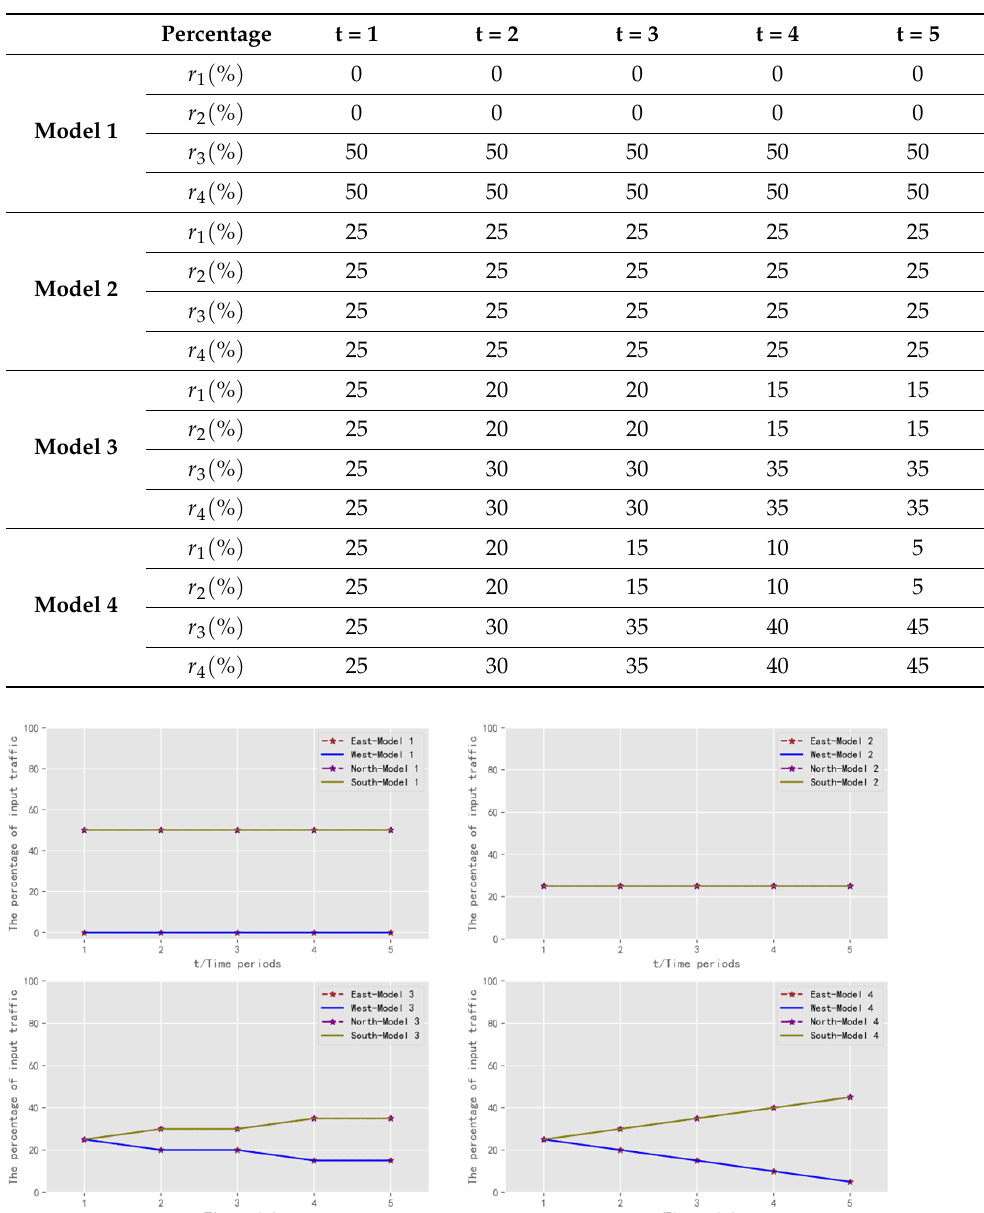
Table 5. Design of traffic scenarios for training: allocation of vehicles in each direction.